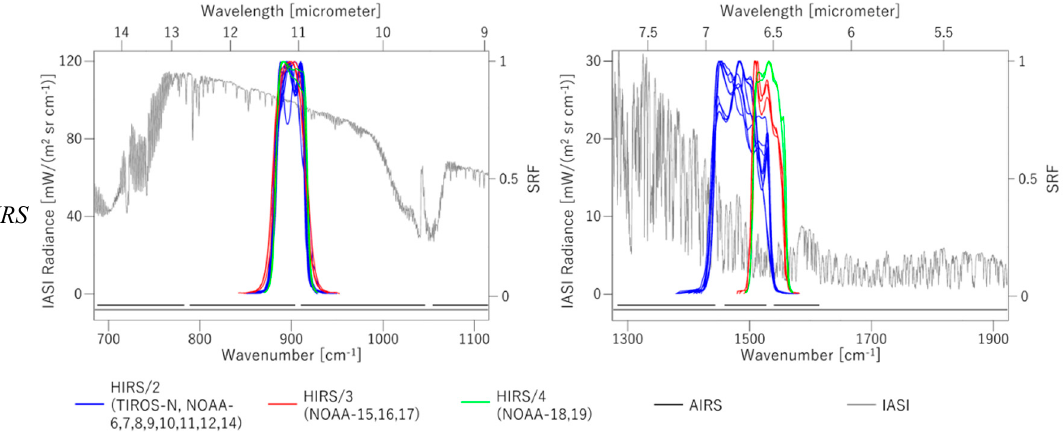
Figure 4. Spectral Response Functions (SRFs) of infrared (IR, left panel) and water vapor (WV, right panel) channels on geostationary (GEO) satellites and those of channel 8 and channel 12 of High-resolution Infrared Radiation Sounder (HIRS) instruments. The bottom grey and black line in those four figures represents spectral coverage of each channel of Infrared Atmospheric Sounding Interferometer (IASI) and Atmospheric Infrared Sounder (AIRS), respectively. Those lines show that AIRS has some gap-channels in the range of SRFs of GEO IR and WV channel, whereas IASI has no gap-channels. The background line in those four panels is typical radiance of each spectrum (the left y axis, unit: mW/(m 2 sr cm -1 ).